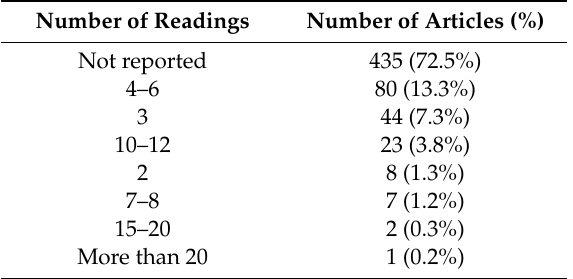
Table 7. Data for technical replicates studied for measuring milk